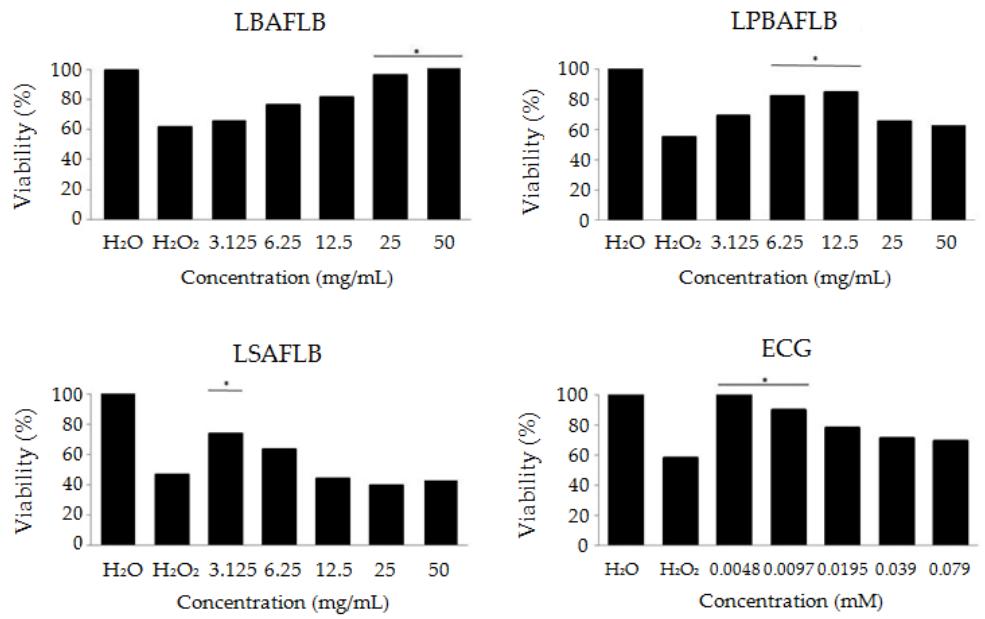
Figure 2. Antitoxicity levels of lyophilised blond alcohol-free lager beer (LBAFLB), lyophilised pale-blond alcohol-free lager beer (LPBAFLB), lyophilised stout alcohol-free lager beer (LSAFLB) and epicatechin gallate (ECG) in D. melanogaster. Data are expressed as percentage of surviving adults with respect to 300 untreated 72-h-old larvae from three independent experiments treated with different concentrations of LBAFLB, LPBAFLB, LSAFLB and ECG combined with 0.12 M H 2 O 2 . *: Chi-square > 3.84 ( p < 0.05). Table 3. Antigenotoxicity of lyophilised blond alcohol-free lager beer (LBAFLB), lyophilised pale- blond alcohol-free lager beer (LPBAFLB), lyophilised stout alcohol-free lager beer (LSAFLB) and epicatechin gallate (ECG) in the Drosophila wing spot test. Clones Per Wing (No. of Spots) (1)